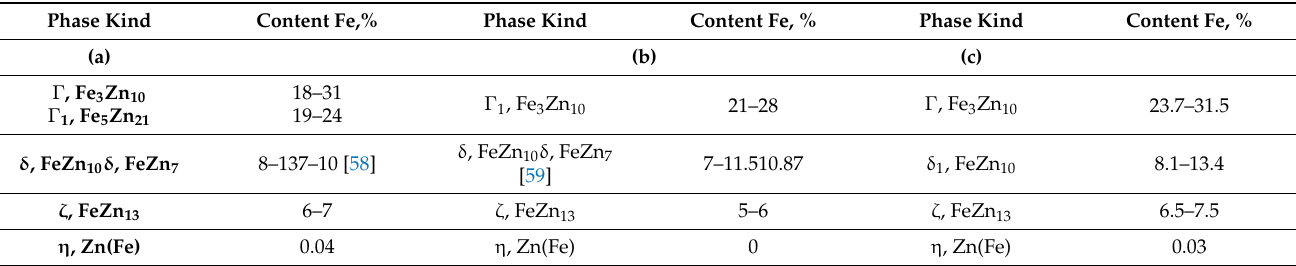
Table 3. The content of iron in individual intermetallic phases of the zinc coating, deposited by ho-dip zinc galvanizing, according to: J. D. Culcasi et al. [54] ( a ), D. Kopyci´nski et al. [56] ( b ) and H. Kania et al. [57] ( c